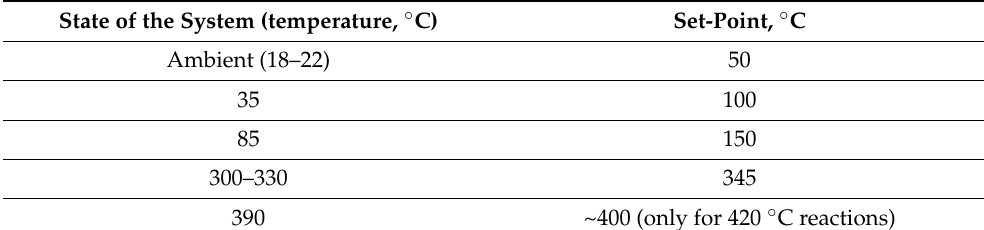
Table 1. Summary of heating ramp